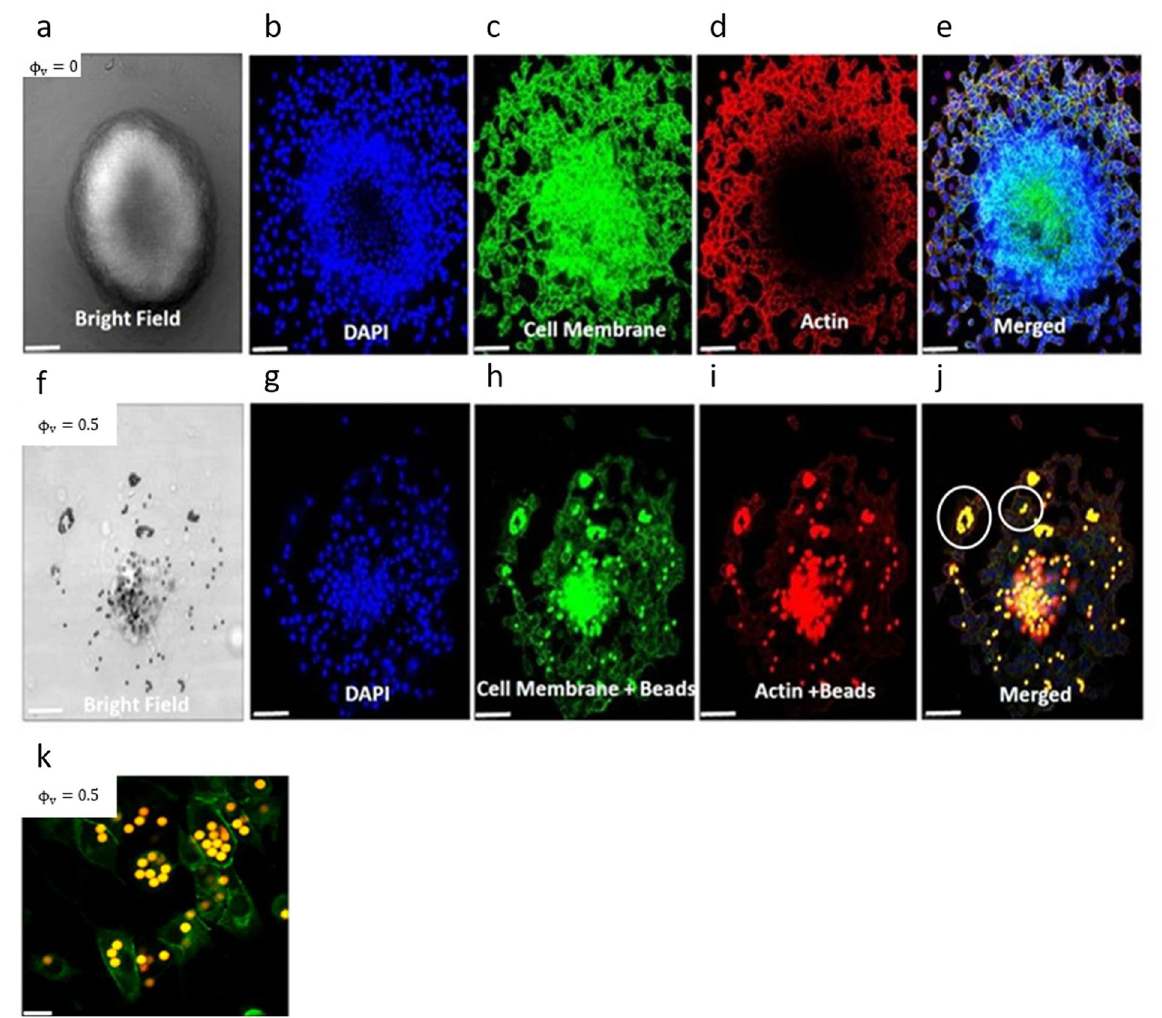
Fig. 7 Bright fi eld and confocal microscopy imaging of spread hybrid aggregates. a Bright- fi eld image of a cell aggregate without microparticles (MPs) after spreading for about 24 h. b – e Confocal images of the same aggregates with on image ( b ) the fl uorescence of the nucleus of the cells using DAPI (4 ′ ,6-diamidino-2-phenylindole), on the image ( c ) the fl uorescence of the cell membrane and MPs, on the image ( d ) the fl uorescence of actin and MPs, and on the image ( e ) the fl uorescence of merged pictures ( b – d ). f Bright- fi eld image of a cell aggregate with Ps-10 (volume fraction of MPs Ф V = 0.5) MPs after spreading for about 24 h. g – j Confocal images of the same aggregate. g The fl uorescence of the nucleus of the cells using DAPI, on the image ( h ) the fl uorescence of the cell membrane and MPs, on the image ( i ) the fl uorescence of actin and MPs, and on the image ( j ) the fl uorescence of merged pictures ( b – d ). The white circles highlight cells that have engulfed several MPs. k Zoom of a spread aggregate with Ps-10 ( Ф V = 0.5) after spreading for about 24 h. Scale bars are equal to 100 μ m on ( a – j ) and to 25 μ m on ( k